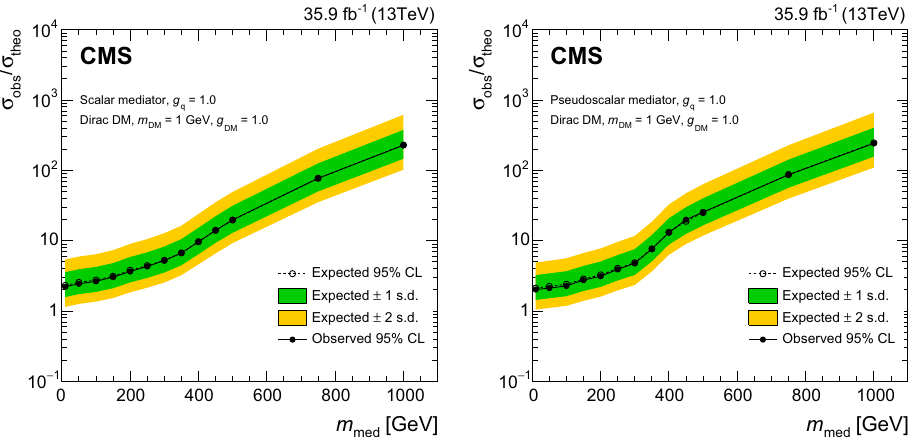
Fig. 6 The 95% CL expected and observed limits on σ obs /σ theo for the scalar (left) and pseudoscalar (right) mediated DM scenario with g q = g DM = 1. The limits are parameterized as a function of mediator mass m med for a fixed dark matter mass m DM = 1GeV